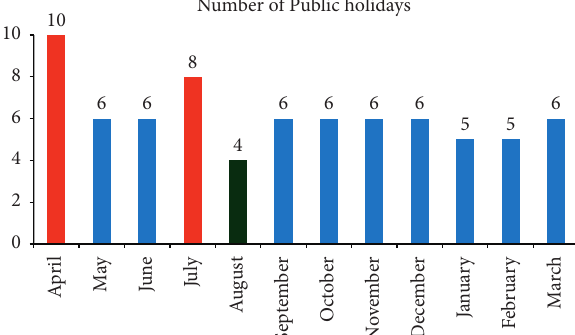
Figure 6: Number of public holidays in each month of 2019.